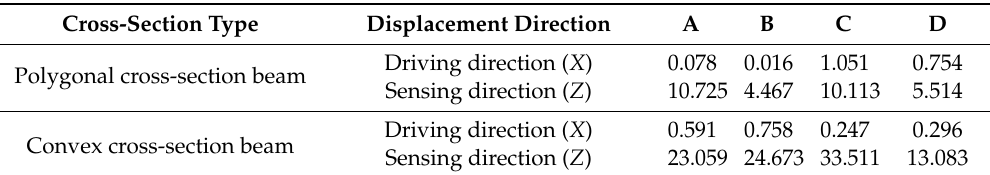
Table 4. The changes in displacement (unit: